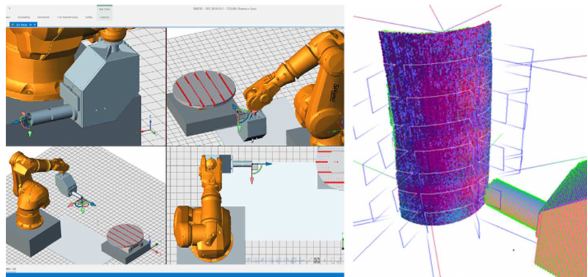
Fig. 7. Simulation of the cleaning process directly on the point cloud allows the cleaning tracks to be optimized with a focus on the areas that have not yet been decoated.